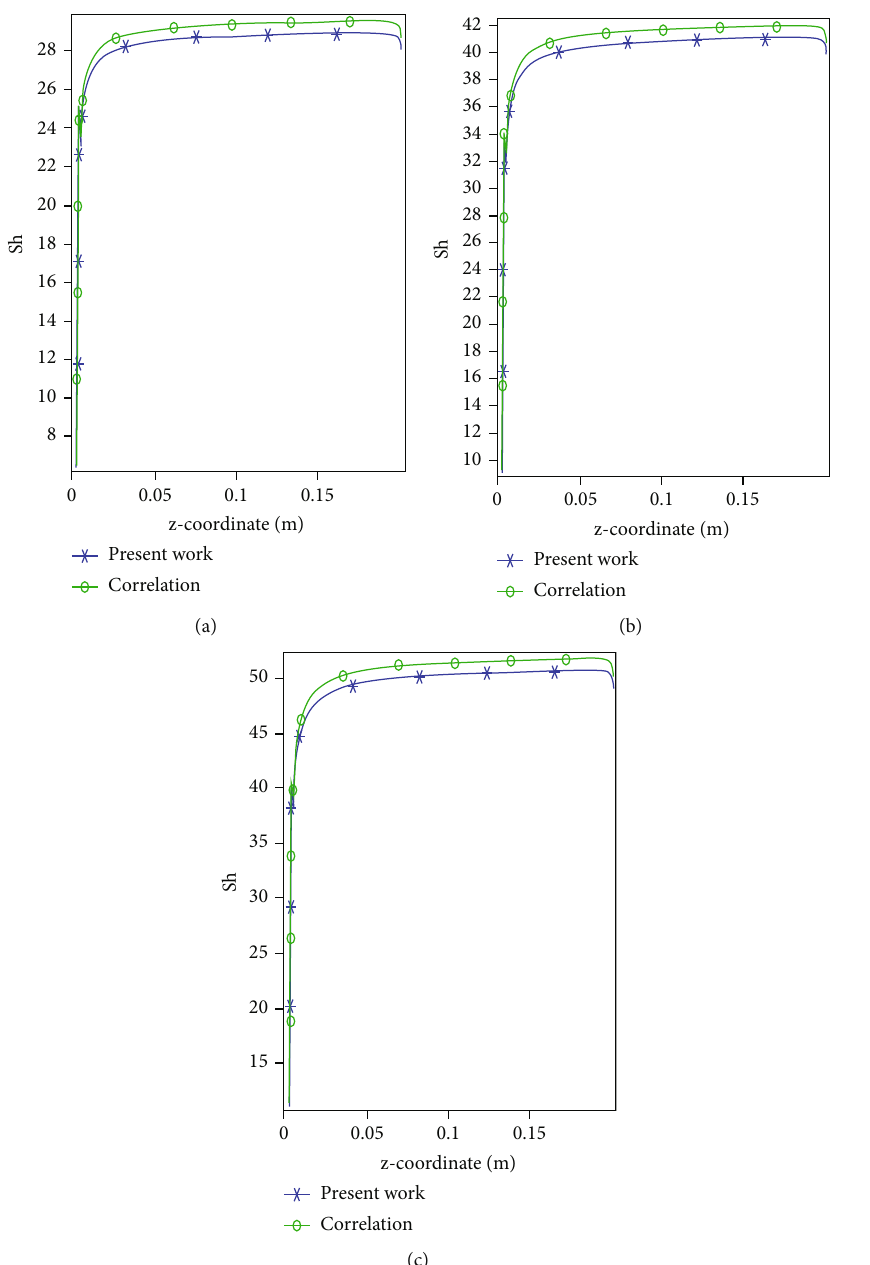
Figure 4: The comparison of the Sherwood number at the vicinity of inlet with the correlation available from the literature at E = 71,000 J/ mol: (a) Re = 100 , (b) Re = 200 , and (c) Re = 300